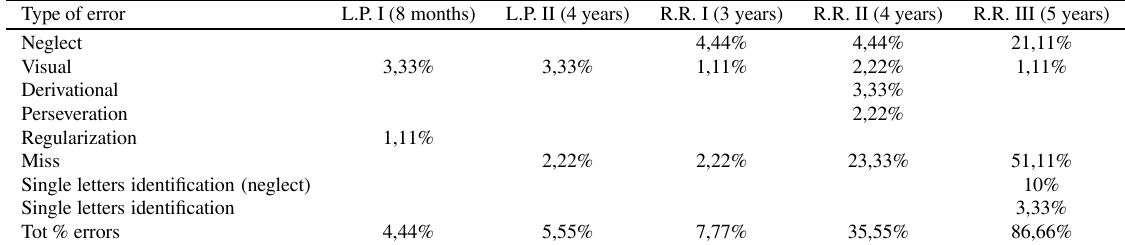
Table 3 Rates of different types of errors at different examinations for L.P. and R.R.